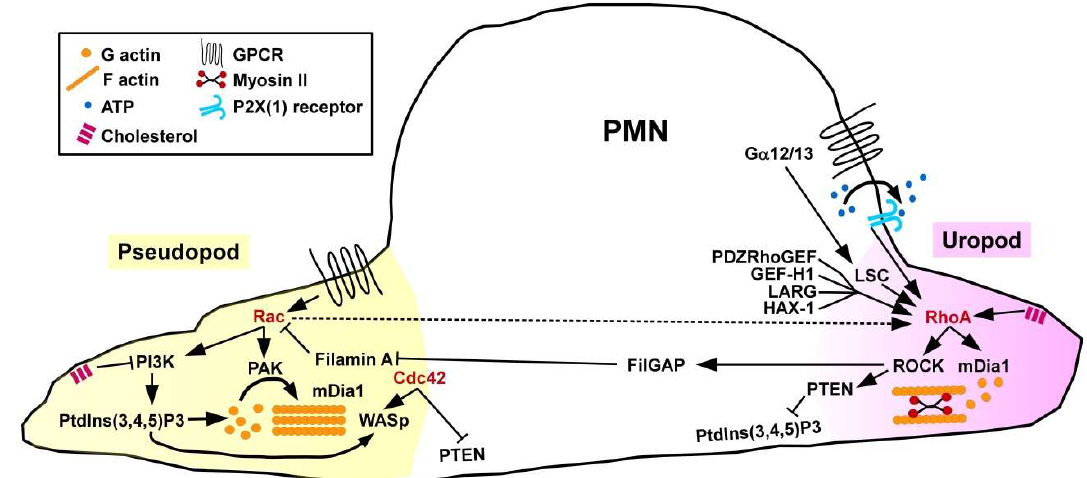
Figure 2. Spatially regulated activity of RhoA and other small GTPases is necessary for coordinated PMN migration. Chemoattractants induce Rac/Cdc42 activation at the migration front (pseudopod), and RhoA activty at the cells´ rear end (uropod). Spatial regulation of small GTPase activity is mediated by localized activity of GEF (e.g., LSC, GEF-H1), and GTPase-induced activation/inhibition of GAP (e.g., FilGAP), other adaptor factors, like PTEN, and PI3K signaling. PMN migration requires mutual inhibition of Rac and RhoA which is mediated by several mechanisms. For example, RhoA via ROCK activation mediates phosphorylation of the Rac1-specific